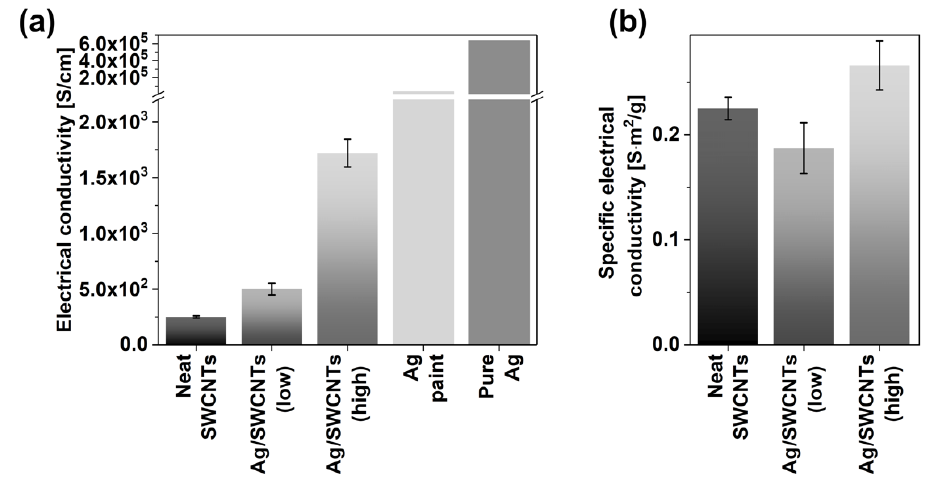
Figure 4. ( a ) Electrical conductivity of the SWCNT films before and after doping with a low and high amount of Ag conductive paint. The conductivity of Ag conducitve paint and pure Ag are taken from the literature and given as a reference [37,51]. ( b ) Specific electrical conductivity of the SWCNT films before and after doping with a low and high amount of Ag conductive paint.